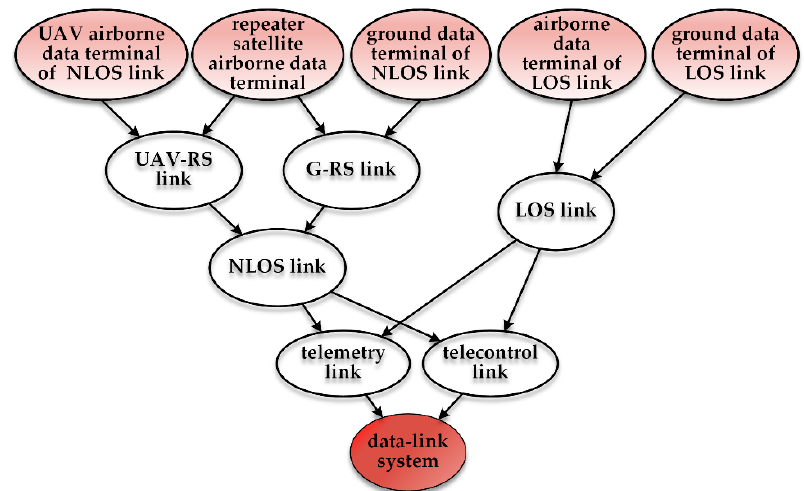
Figure 4. Directed acyclic graph of UAV data-link. LOS: line-of-sight; NLOS: non-line-of-sight; UAV-RS: UAV repeater satellite; G-RS: ground data terminal repeater satellite.